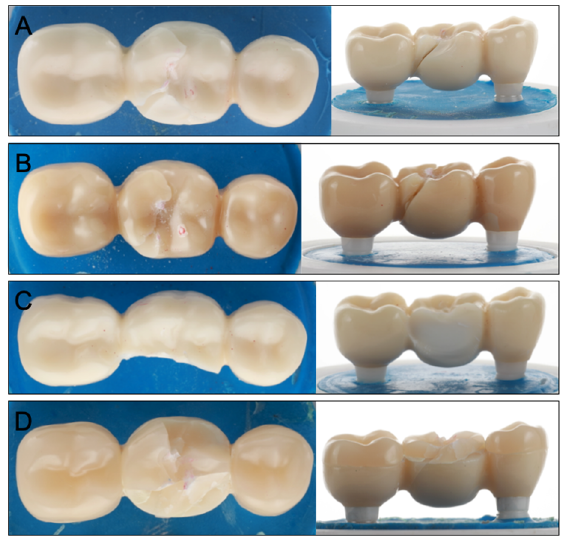
Figure 5. Representative samples of all Groups after single-load-to-fracture assessment. Light microscopy shows ( A ) occlusal and side view of Group Z-HT, bulk fracture of FDP within the distal connector ( B ) Group Z-ST, bulk fracture of FDP within the distal connector ( C ) Group FL, bulk fracture without involvement of the distal connector ( D ) Group RL, chipping fracture of PICN and bulk fracture of the zirconia framework. Table 4. Failure analysis of FDPs after SLF. Chipping of Group RL is referred to the PICN Tabletop.